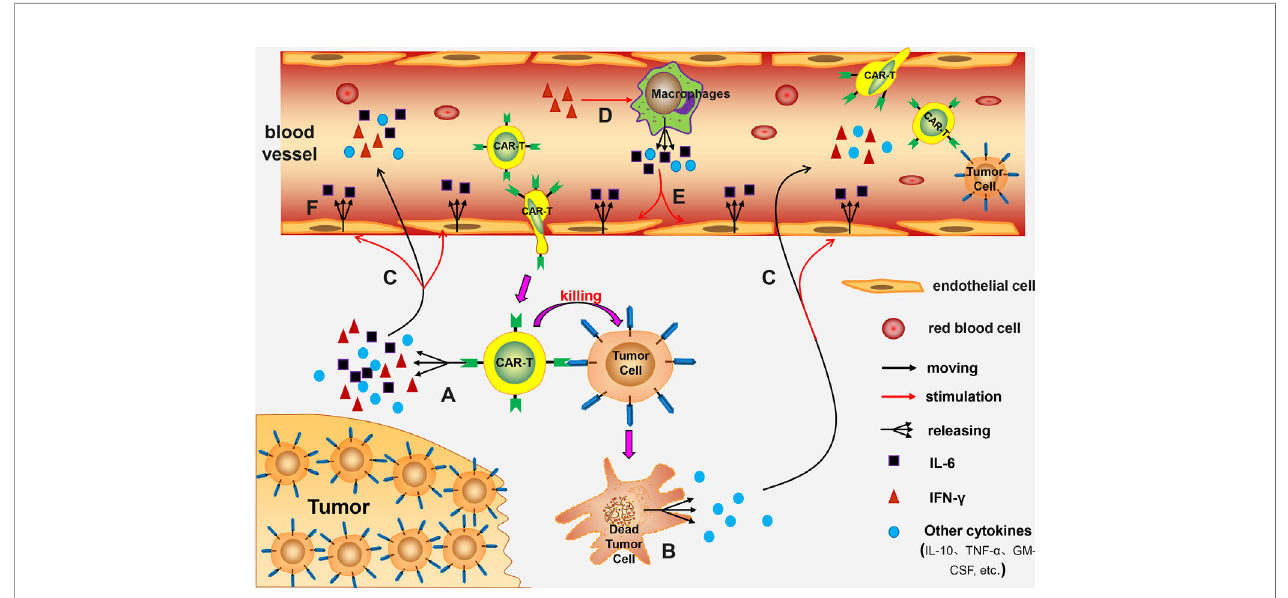
FIGURE 1 | The mechanism of CRS. (A) Activated CAR-T cells release numerous cytokines; (B) The lysed tumor cells release a large number of cytokines; (C) These cytokines enter the blood circulation and activate endothelial cells; (D) IFN- g further induces macrophages activation; (E) The activated macrophages release many cytokines into the blood circulation which activate endothelial cells; (F) The activated endothelial cells release large amounts of IL-6, forming a vicious